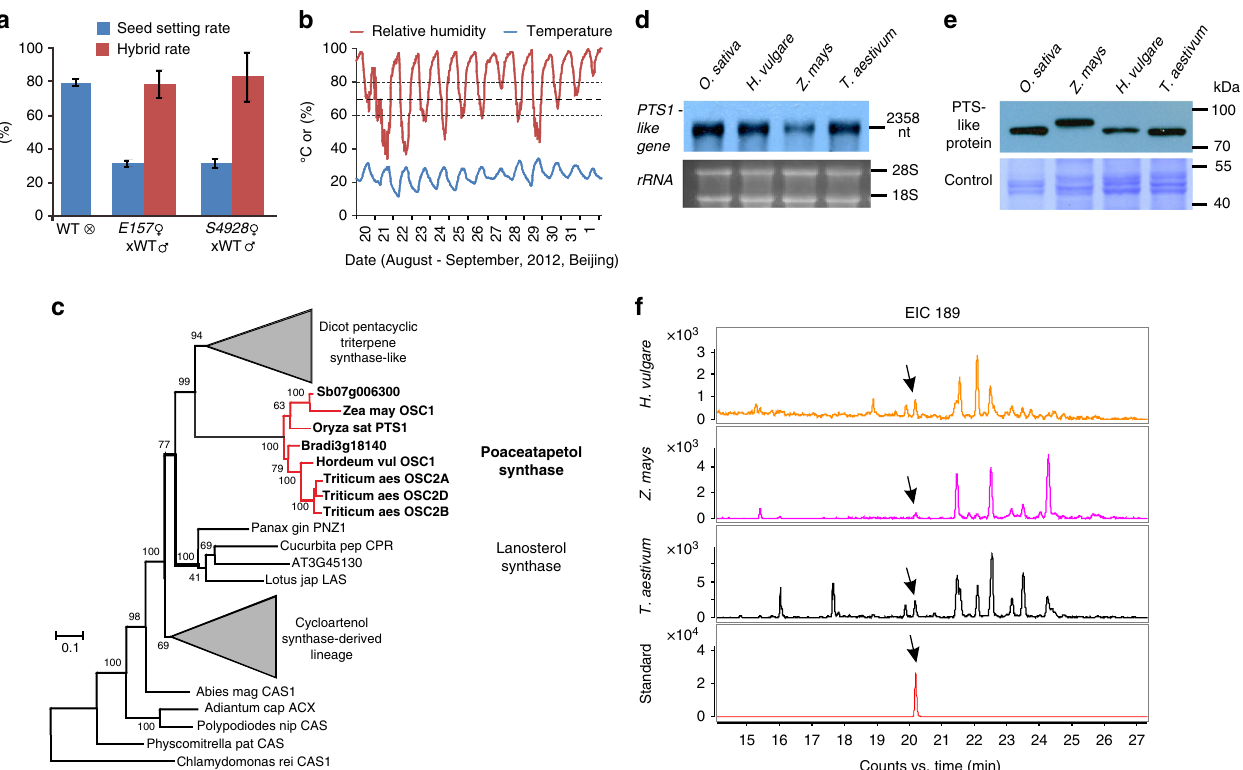
Counts vs. time Fig. 6 HGMS-based hybrid seed production. a Seed setting rate and hybrid rate of the crosses of E157 and S4928 plants, with the WT plants. The data are presented as mean ± s.d., n = 15 panicles for seed setting rate, n = 300 seeds for hybrid rate. b The variation in RH and temperature at the fi eld site over the period of anthesis. Data were recorded at 1 h intervals by a detector suspended 10 cm above the canopy. c A simpli fi ed phylogeny of plant OSCs, based on their coding sequence. A maximum likelihood tree was constructed assuming the GTR + Γ + I model. The gray triangles indicate groups of OSCs derived from the same lineage. Sequences shown in bold indicate poaceatapetol synthase-like genes. d Northern blotting analysis of transcription in the anthers of four major cereal species. e Western blotting demonstrates the presence of OsOSC12-like proteins in the anthers of other cereal species. f The GC/MS pro fi le of the triterpene alcohol fraction of extracts of barley, maize and wheat anthers. Standard, puri fi ed poaceatapetol; EIC 189, extracted ion chromatograms at m/z 189. The arrow indicates the poaceatapetol